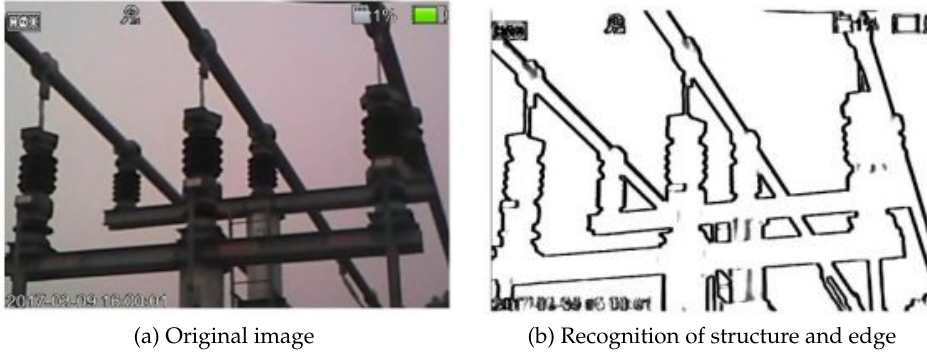
Fig. 1. Identifying edge areas using local variations